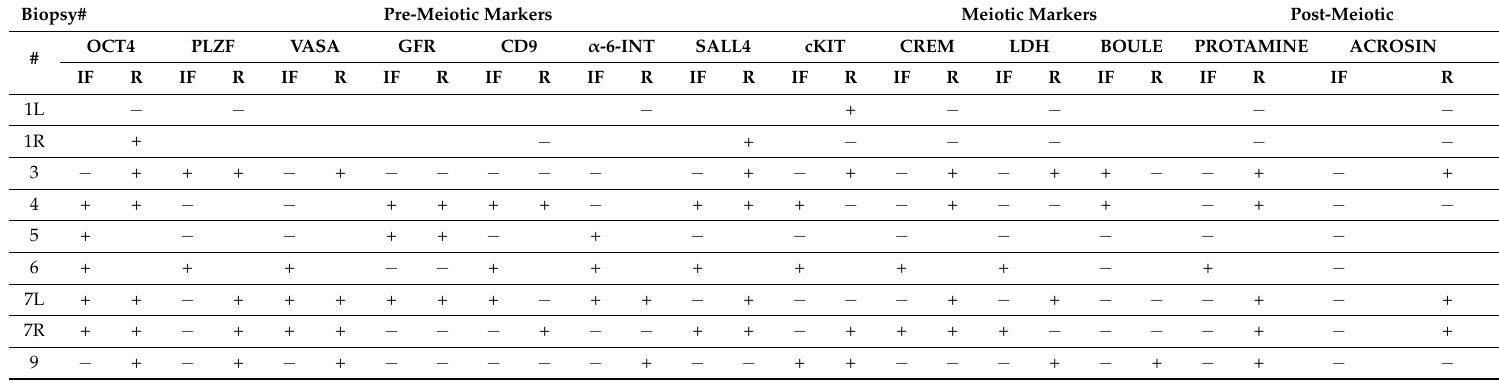
Table 2. Presence/expression of spermatogenic markers in isolated cells from testicular biopsies without sperm of SCOS patients before in vitro culture: Isolated cells from biopsies without the sperm ( n = 9) of SCOS patients were examined for premeiotic markers (OCT4, PLZF, VASA, GFRa1, CD9, α -6-Integrin, SALL4, and c-KIT) by immunofluorescence staining (IF) or by PCR analysis (R) using specific primary antibodies or primers (respectively) for each marker. The results (+) or ( − ) indicate the presence or absence (respectively) of the examined makers. Empty rectangles—indicate not examined. L—a biopsy from the left testis; R—a biopsy from the right